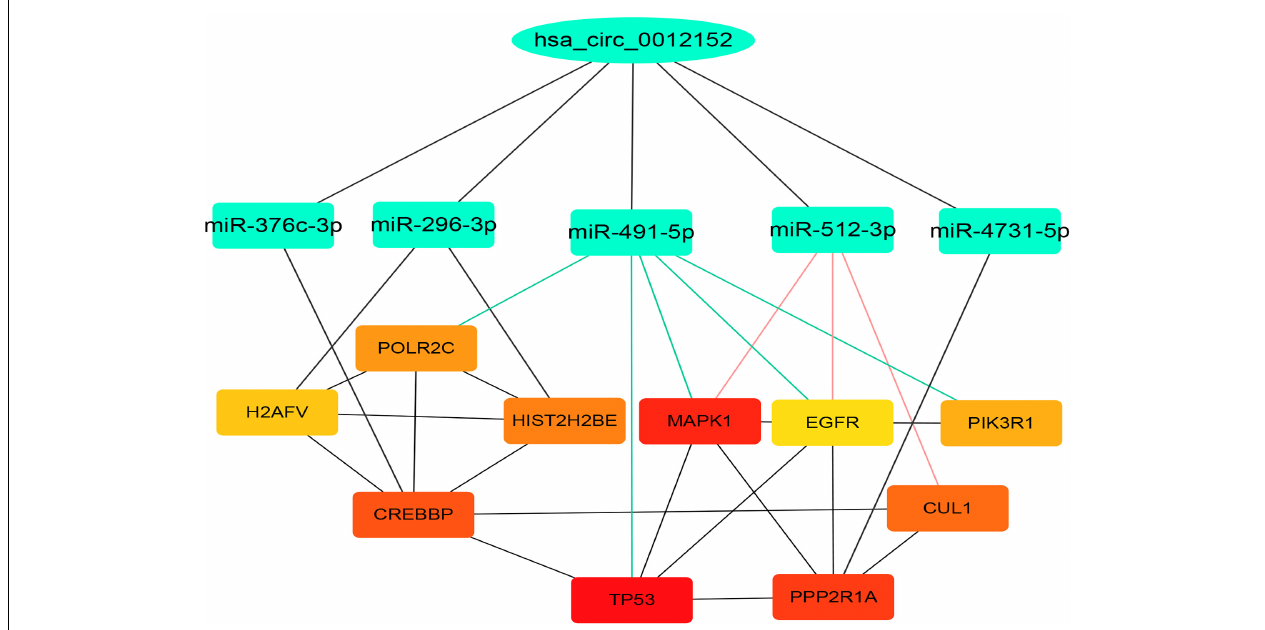
FIGURE 5 | Competing endogenous RNA (ceRNA) network indicating the potential functioning mechanism of hsa_circ_0012152. The top layer shows hsa_circ_0012152, the middle layer shows the five target microRNAs (miRNAs) of hsa_circ_0012152, and the bottom layer shows the target gens of miRNA. The lines between the boxes represent the interaction